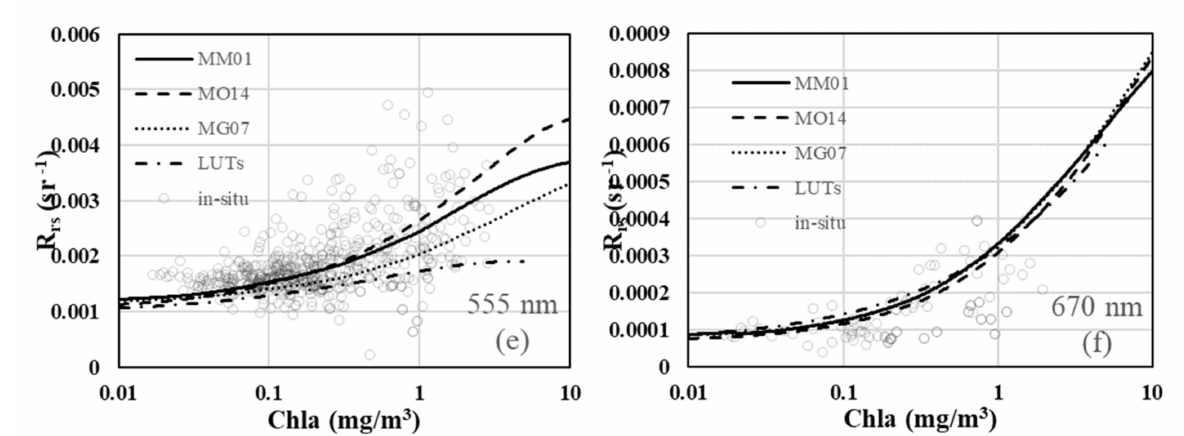
Figure 7. Differences in R rs ( λ ) between of the MM01, MG07, MO14, and LUTs models and in situ data, when the concentration of chlorophyll was 0.01–10mg m − 3 (( a ) 412 nm, ( b ) 443 nm, ( c ) 488 nm, ( d ) 510 nm, ( e ) 555 nm, ( f ) 670